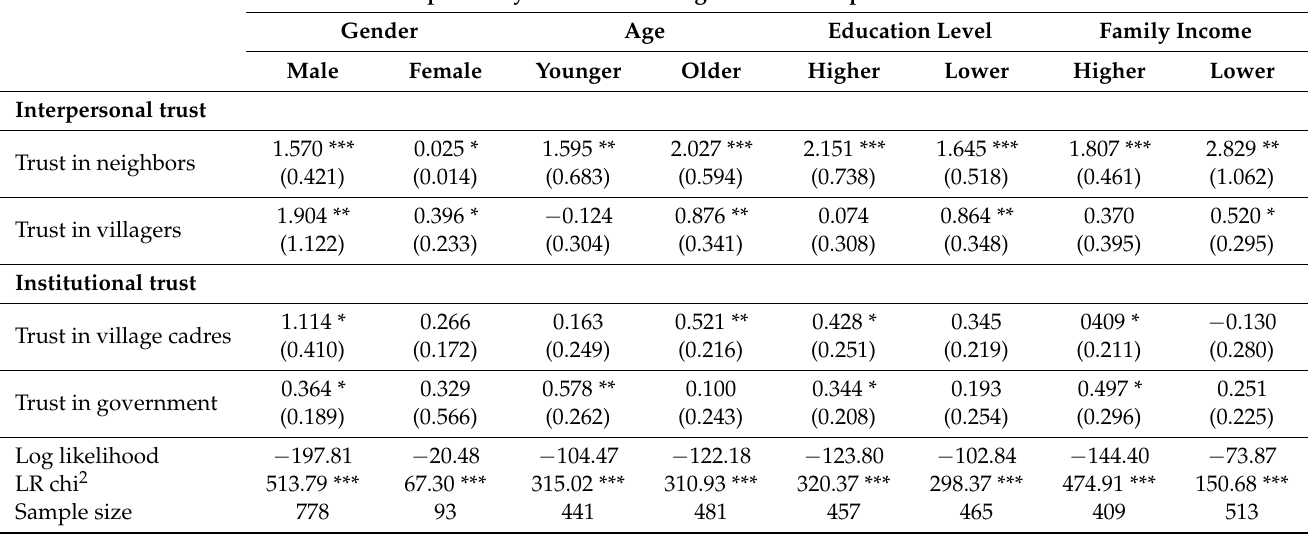
Table 4. Results of heterogeneity